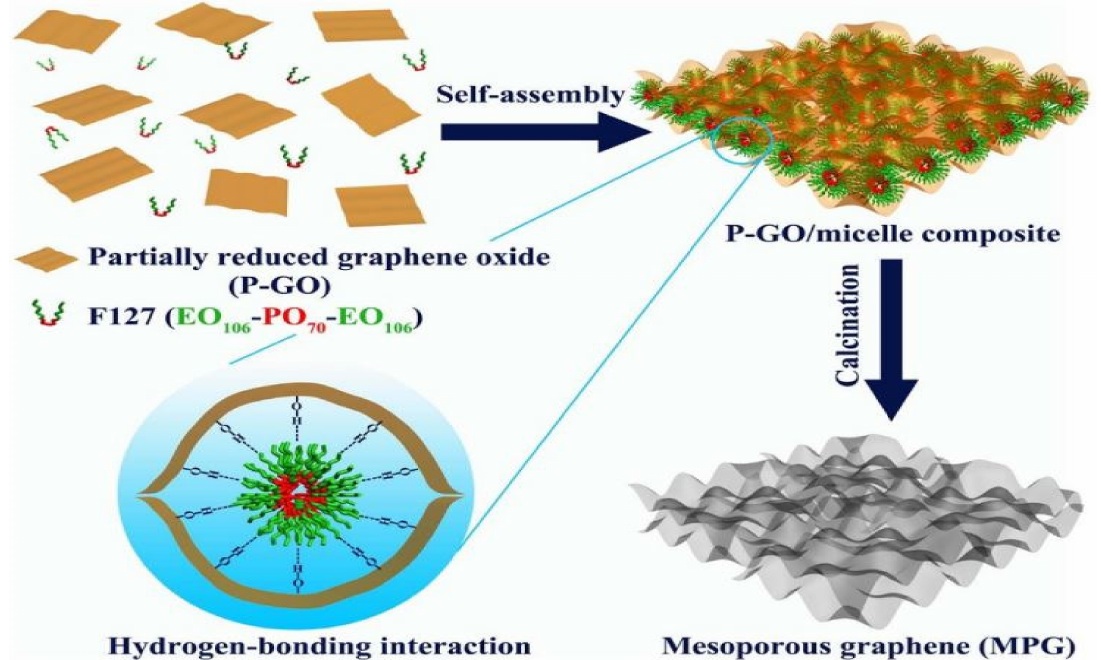
Figure 15. Schematic illustration for preparing mesoporous graphene. (Reprinted with permission from reference [161]. Copyright 2014, Nature Publishing